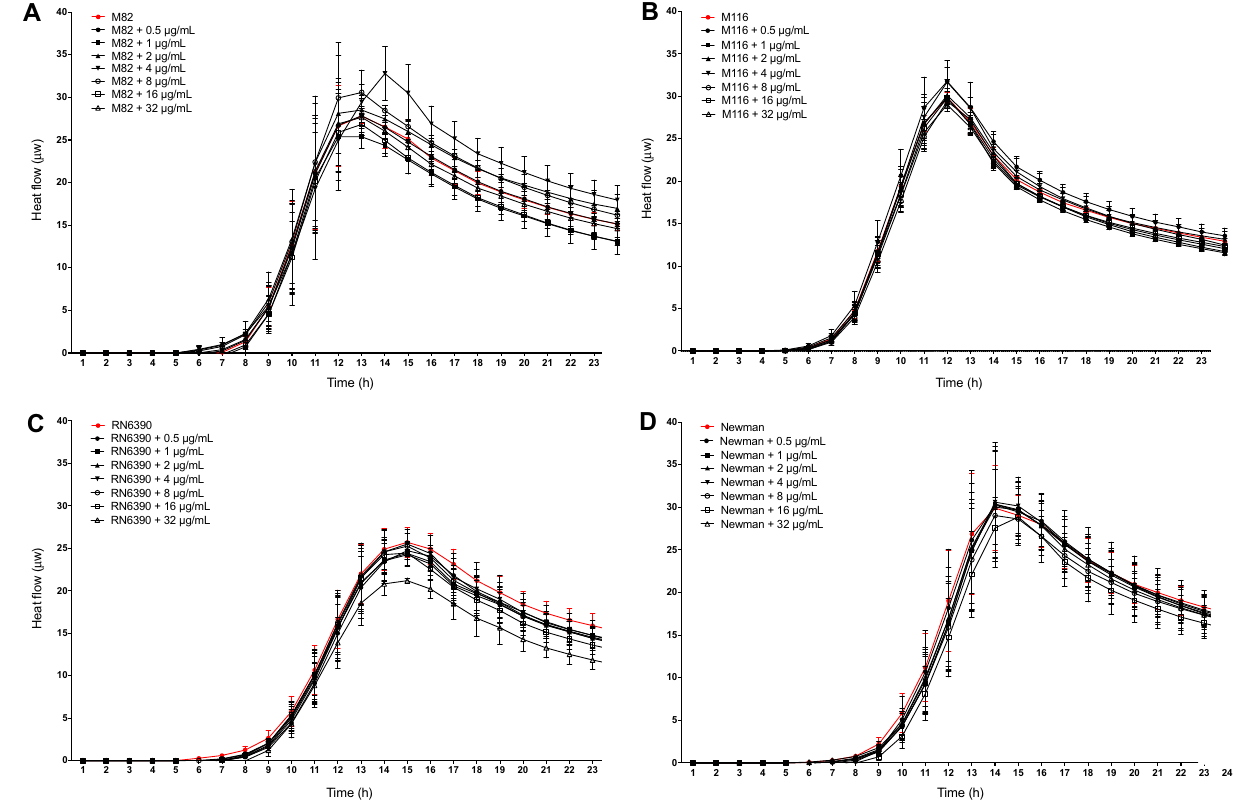
Figure 3. The metabolic rate of biofilms in the presence of different dosages of paracetamol. Metabolic heat flow generated during overnight biofilm formation at 37 °C and co-incubation without (red line) or with 0.5– 32 µg/mL paracetamol of S. aureus CC20 strain M82 ( A ) and CC8 strains; M116 ( B ), RN6390 ( C ), and Newman ( D ) were monitored with isothermal microcalorimetry in real-time. Data from three separate experiments are presented as mean value and